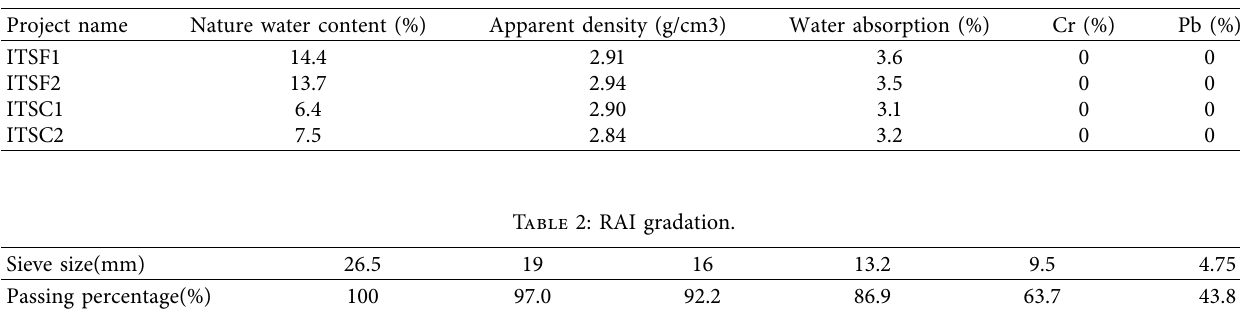
Figure 2: Four types of ITS. Table 1: Technical indexes of ITS.